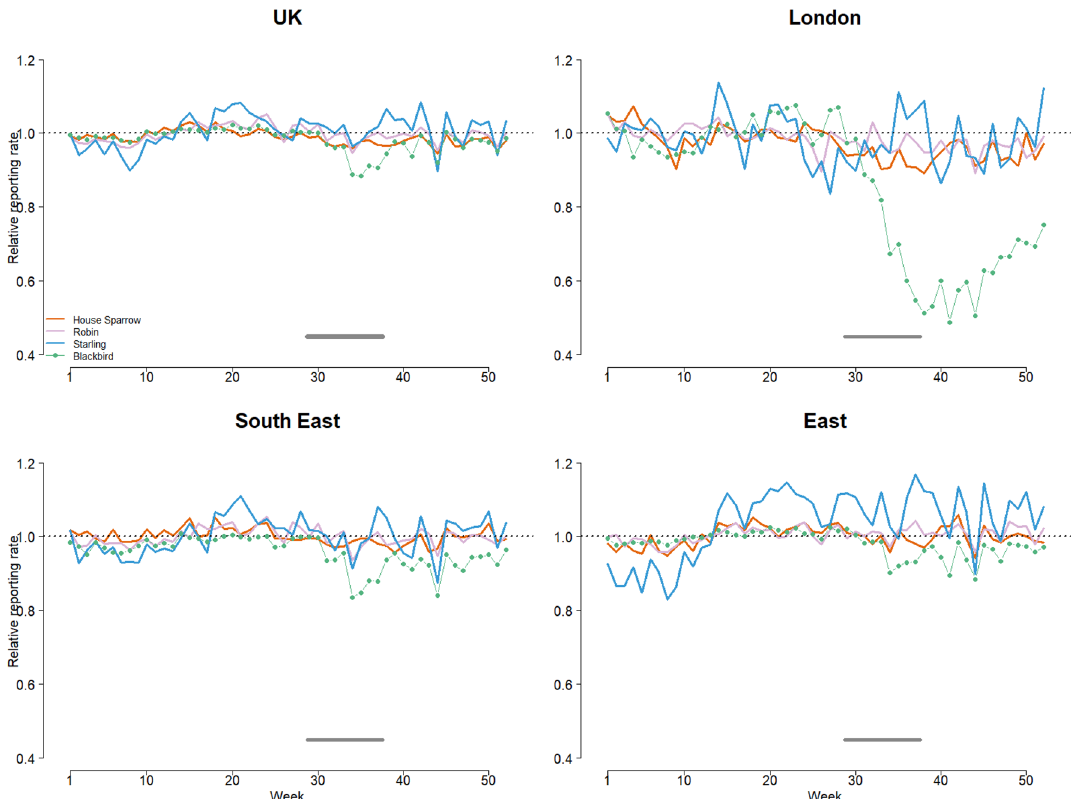
Figure 4. Relative weekly reporting rate in 2020 for Eurasian blackbird ( Turdus merula ), house sparrow ( Passer domesticus ), robin ( Erithacus rubecula ) and starling ( Sturnus vulgaris ) throughout the year. Data from British Trust for Ornithology’s Garden BirdWatch survey. Weeks are numbered from 1 (1st week of January) through 52 (last week of December) and a relative reporting rate of 1 indicates the presence of a species in a similar proportion of gardens in 2020 compared to the 2011–2019 average. The grey horizontal line represents the period from first USUV detection (15th July 2020) through blackbird post-mortem examination and latest detection (17th September 2020) through mosquito surveillance and molecular